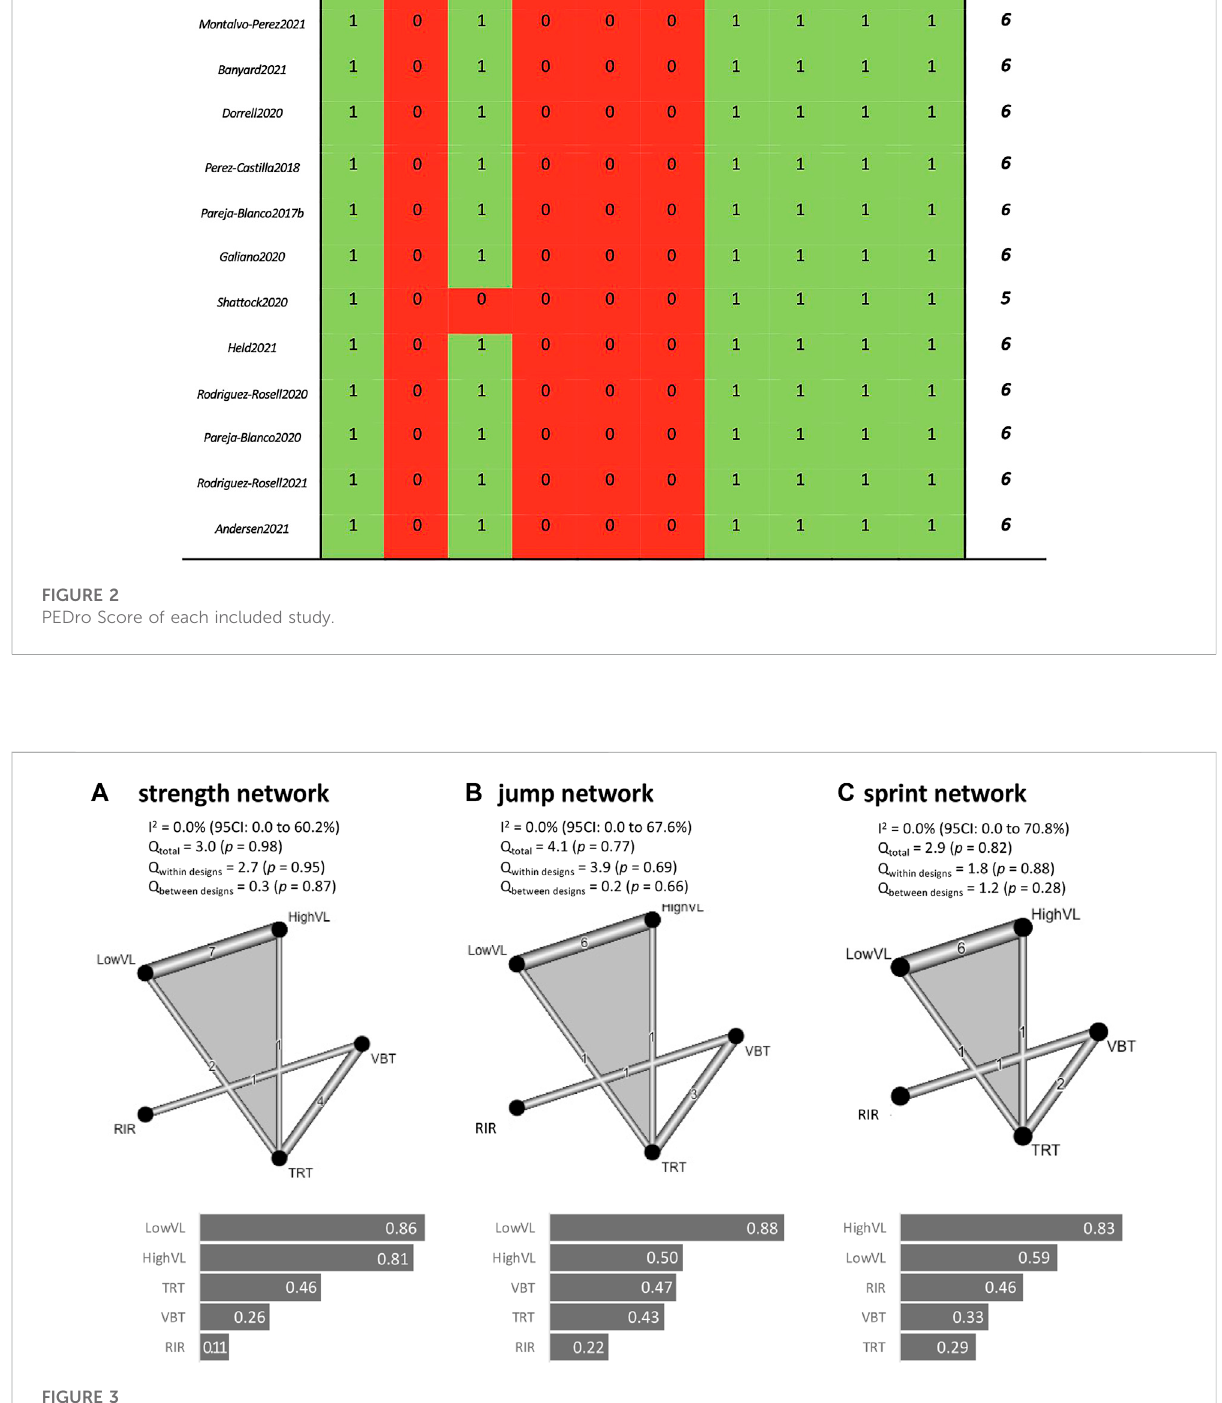
FIGURE 3 Networkplotsofthestrength (A) ,jump (B) ,andsprint (C) network.Inaddition,I 2 ,Qstatistic,andP-scorerankingsaregiven.LowVL:lowvelocity loss( ≤ 20%);HighVL:highvelocityloss( > 20%);RIR:repetitionsinreserve-basedtraining;VBT:velocity-basedresistancetraining;TRT:traditional1RM based resistance training